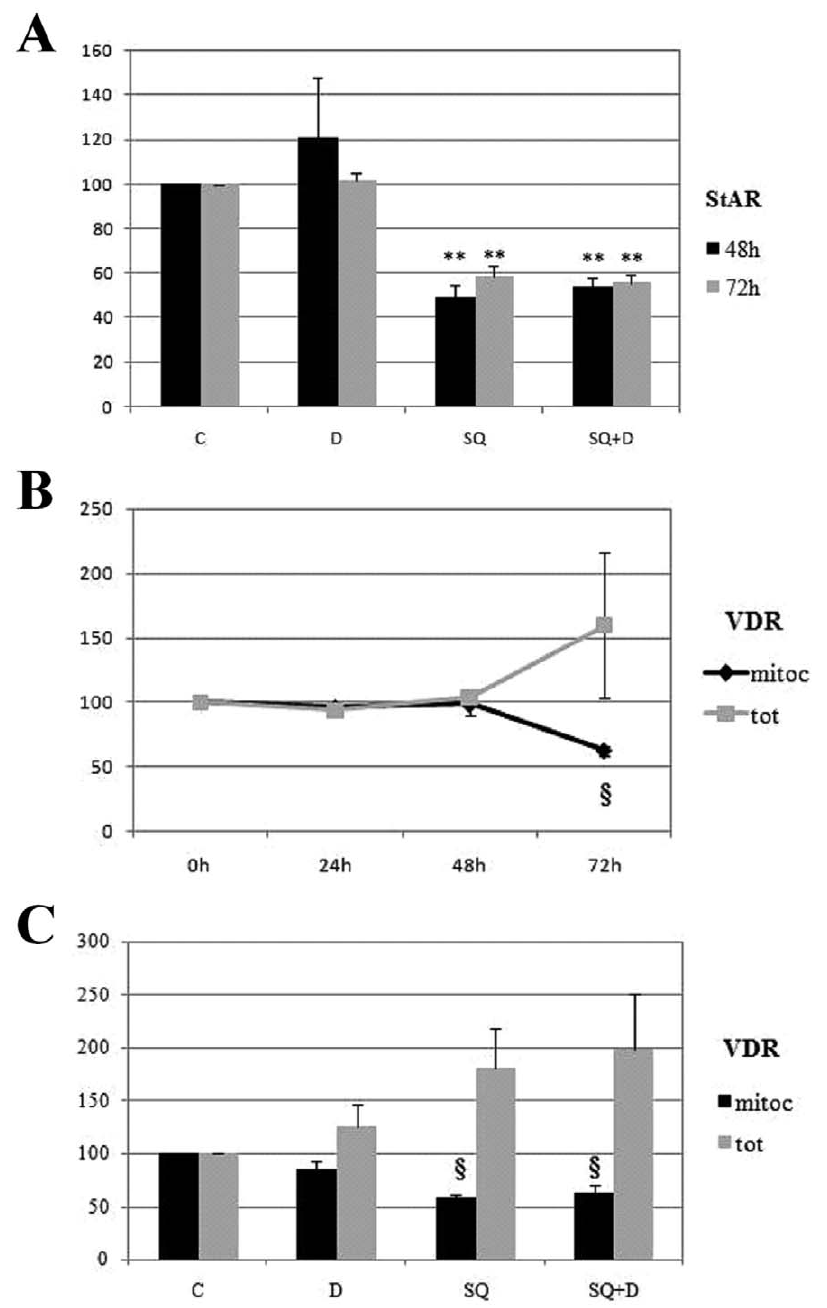
Figure 4. Effect of squalestatin treatment on StAR and VDR expression. HaCaT cells were treated with squalestatin (SQ) and 100 nM 1,25D3 (D) or left untreated (control, C), harvested and 50 m g of total lysates (tot) or 30 m g of mitochondrial proteins (mitoc) were analysed by western blotting for StAR and VDR expression. Bands were quantified, normalized for loading as a ratio to actin expression (tot) or VDAC expression (mitoc) and data plotted on graph as percentage of control. Data represent the mean 6 S.D of three independent experiments. (A) Analysis of StAR expression in mitochondrial fractions after 48 or 72 hours of treatment with SQ, 24 hours with vit. D or cotreatment in which vit. D was added in the last 24 hours (SQ + D). (B) VDR expression after squalestatin treatment in a time course experiment. (C) VDR expression after 72 hours of the same treatments as in (A). 1 p , 0.01 and ** p , 0.001 compared to control.